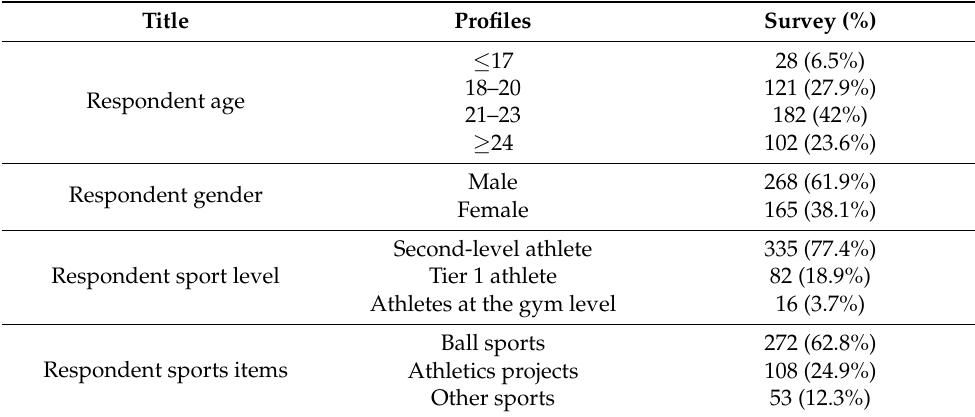
Table 1. Participant profile (N = 433) .